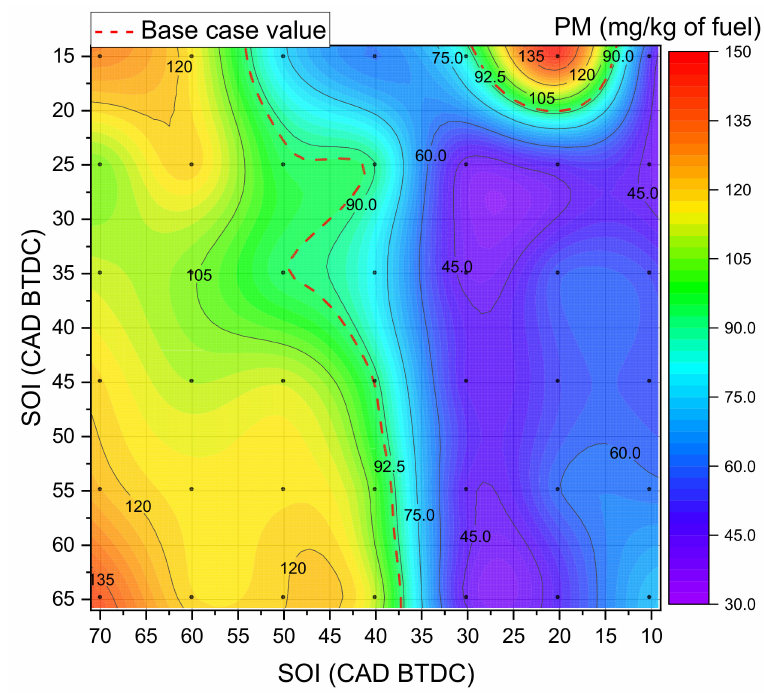
Figure 11. Particulate matter contour